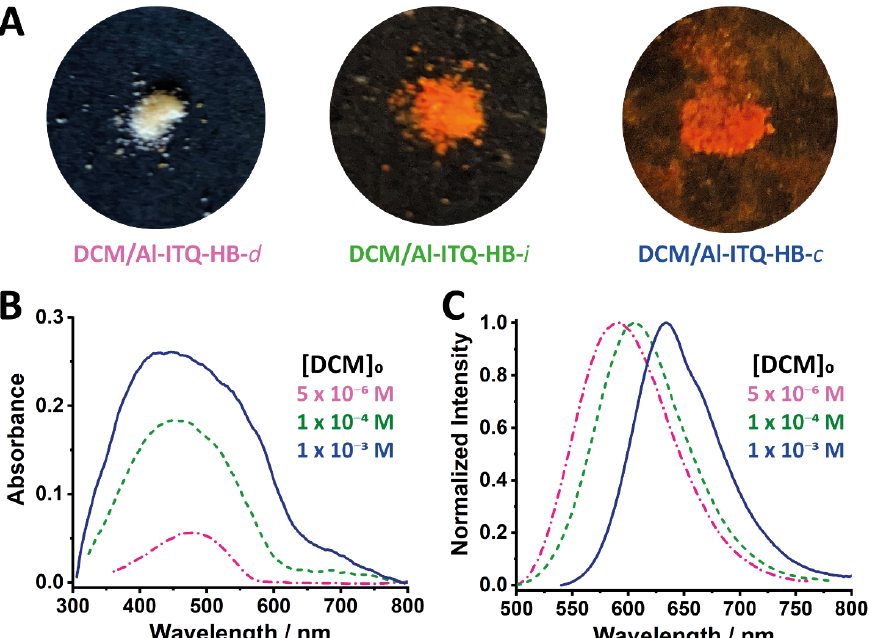
Figure 1. ( A ) Photographs of the hybrid composites (under daylight) containing increasing amounts of DCM. UV-visible absorption ( B ) and emission ( C ) spectra of DCM/Al-ITQ-HB in the solid-state at different dye concentrations: 1 × 10 − 3 M (blue solid line), 1 × 10 − 4 M (green dashed line), and 5 × 10 − 6 M (pink dashed-dotted line). Each absorption spectrum has been corrected by subtracting the absorption from pristine Al-ITQ-HB. For emission spectra, the excitation wavelength is 470 nm. The absorption spectrum of the DCM/Al-ITQ-HB- d composite prepared with a con- centration of [DCM] 0 = 5 × 10 − 6 M exhibits a broad and structureless band with an intensity maximum at 478 nm (Figure 1B). This value is close to the one shown in dichloromethane solutions (466 nm) [30,40,49,50]. Therefore, we assign this band to the S 0 ( π ) → S 1 ( π *) transition. Comparing the FWHM of the main absorption band of DCM in solution (4360 cm − 1 ) and DCM/Al-ITQ-HB- d (6030 cm − 1 ), we observe a band broadening upon interaction with the MOF, which suggests the existence of an heterogenous distribution of DCM mol- ecules in the composites. This is also evidenced by the deviation from the normal Gaussian distribution of the absorption spectrum. On the other hand, the emission spectrum shows a narrow band (FWHM = 2810 cm − 1 ) with its intensity maximum at 590 nm (Figure 1C). The smaller FWHM value of the emission spectrum compared to that obtained from the absorption one indicates the existence of population(s) of surface-adsorbed DCM molecules relaxing to S 0 through fast non-radiative pathways. The spectral Stokes-shift ( ∆ ν max = 3970 cm − 1 ) observed for the DCM/Al-ITQ-HB- d composite, being only slightly abs − em smaller compared to that ( ∆ ν max = 4510 cm − 1 ) observed in a dichloromethane solution, abs − em indicates that an excited-state CT reaction occurs as well for the DCM molecules interacting with the MOF. To further characterize the nature of the DCM species adsorbed on the surface of Al-ITQ-HB, we have studied the photobehavior of two additional samples with increasing concentrations of DCM. The intermediate sample, DCM/Al-ITQ-HB- i , having an initial dye concentration of 1 × 10 − 4 M, shows an even broader absorption spectrum (FWHM = 9360 cm − 1 ), with an intensity maximum at 456 nm (Figure 1B). This indicates a higher heterogeneity of the absorbing DCM species when the initial DCM concentration increases. A new band centred at 660 nm is also detected, being this band reminiscent to the absorption of bulk DCM in solid state, as shown in Figure S2. The emission of this composite is centred at 606 nm, with a Stokes shift of 5430 cm − 1 (Figure 1C). This value is larger than that calculated for the diluted sample (DCM/Al-ITQ-HB- d, 3970 cm − 1 ), revealing a clear dependence of the photobehavior of DCM/Al-ITQ-HB materials on the concentration of DCM. It is worth to note that, while the absorption spectrum